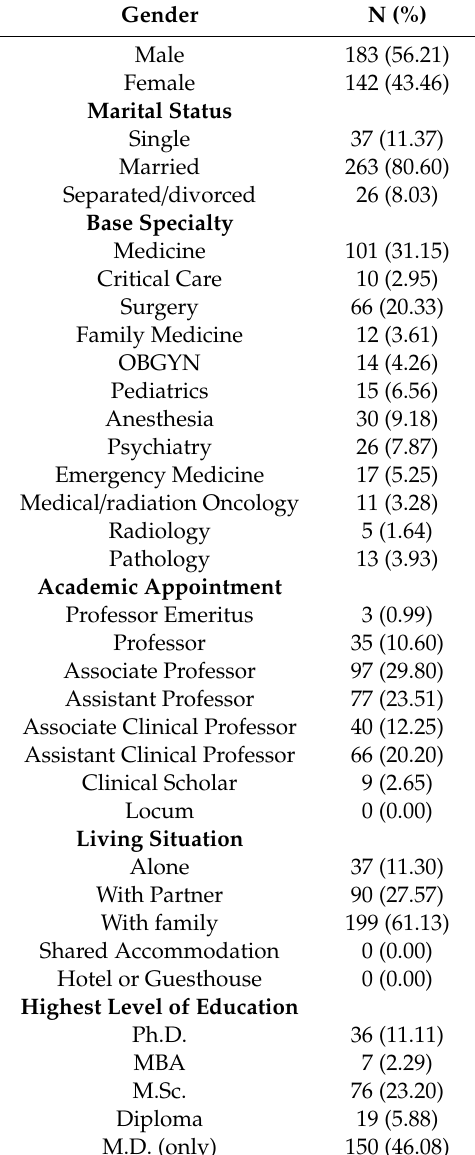
Table 1. Study Demographics ( n =